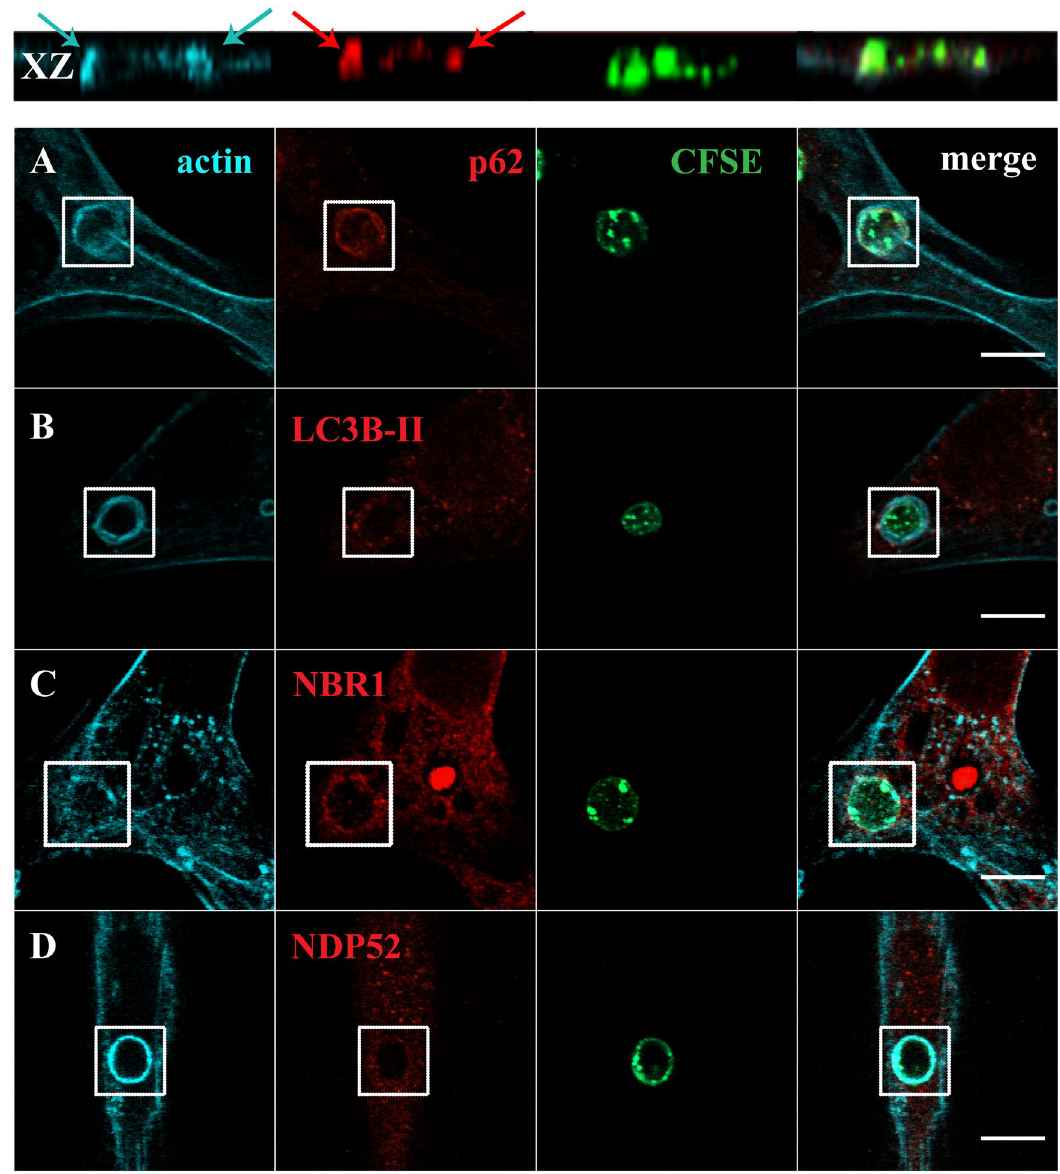
Figure 2. Co - localization of LC3B-II and autophagy adaptor proteins with F-actin in phagosomes containing RBC. Non-professional phagocytes were fed with RBC for 30 min, fixed, and stained for F-actin with Phalloidin and for the endogenous LC3B or autophagy adaptors. ( A – D ) are representative images, obtained by confocal microscopy, of cells co-stained for F-actin and p62 ( A ), LC3B ( B ), NBR1 ( C ) or NDP52 ( D ). In A, side views (XZ) are merges of ten vertical sections of confocal stacks. Arrows indicate the nascent phagosome positive for F-actin (blue) and p62 (red). The first column represents cells stained for F-actin. The second column represents cells stained for the endogenous p62, LC3B-II, NBR1 or NDP52. The third column shows internalized RBC stained with CFSE. The fourth column represents merged images of F-actin with LC3B-II or autophagy adaptors and internalized RBC. The regions outlined by the boxes are nascent phagosomes. Bars, 10 µ